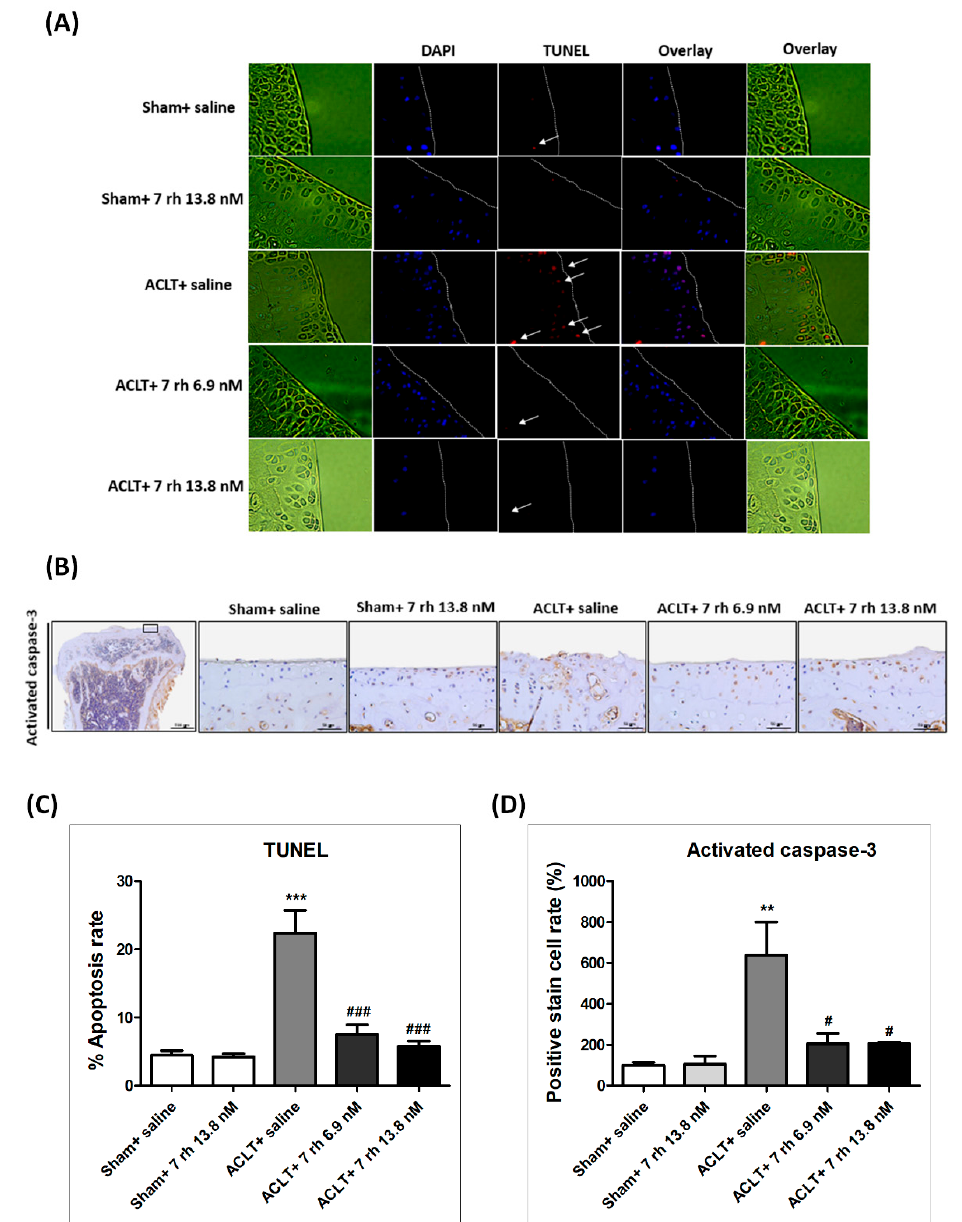
Figure 5. Effect of 7 rh on chondrocyte apoptosis in articular cartilage. ( A ) TUNEL staining in the articular cartilages of the sham control groups (sham + saline and sham + 7 rh 13.8 nM), ACLT, and two 7 rh treating groups. The arrows mean positive stain of TUNEL. ( B ) The representative micrographs of immunolocalized activated caspase 3. ( C ) Quantitative analysis of the apoptotic rate. ( D ) Quantitative analysis of the immunohistochemical staining of activated caspase 3. Each bar represents the mean ± SEM of 12 samples in each group. (** p < 0.01 versus the sham control groups; *** p < 0.001 versus the sham control groups; # p < 0.05 versus the ACLT group; ### p < 0.001 versus the ACLT